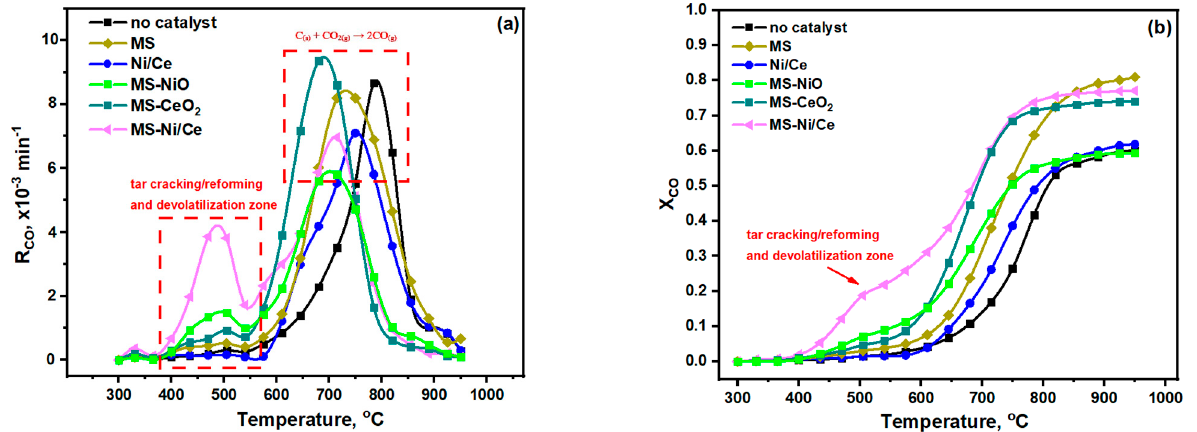
Figure 7. Effect of temperature and catalyst components on the instant CO production rate, R CO ( a ), and carbon to CO conversion ( b ) during non-isothermal CO 2 gasification experiments. Gasifying agent flowrate = 30 cm 3 /min of 20 vol.% CO 2 in